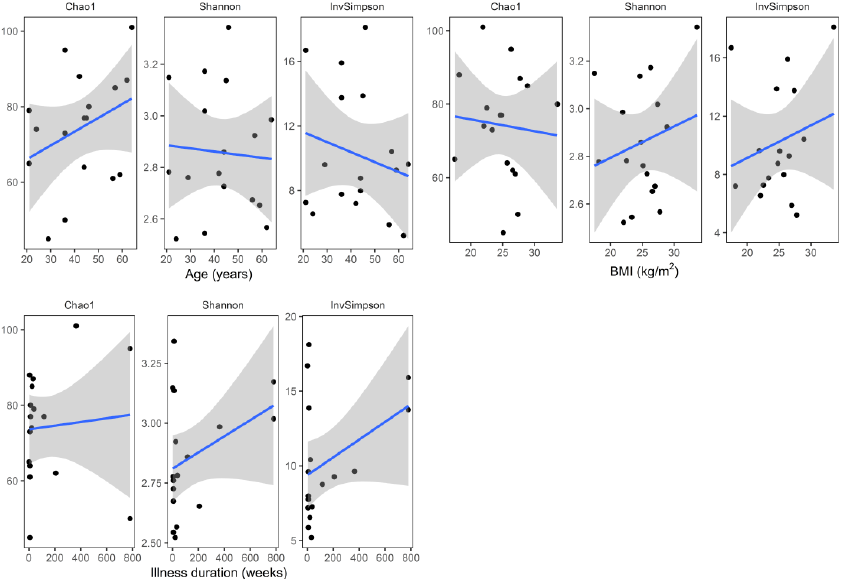
Figure 4. Correlations (scatter plots) between alpha diversity metrics — Chao1, Shannon, and inverse Simpson (invSimpson), and sample metadata (age, BMI, and illness duration) at baseline (W0). The regression lines (colored blue) were fitted using the linear model; grey shading areas represent confidence bounds.